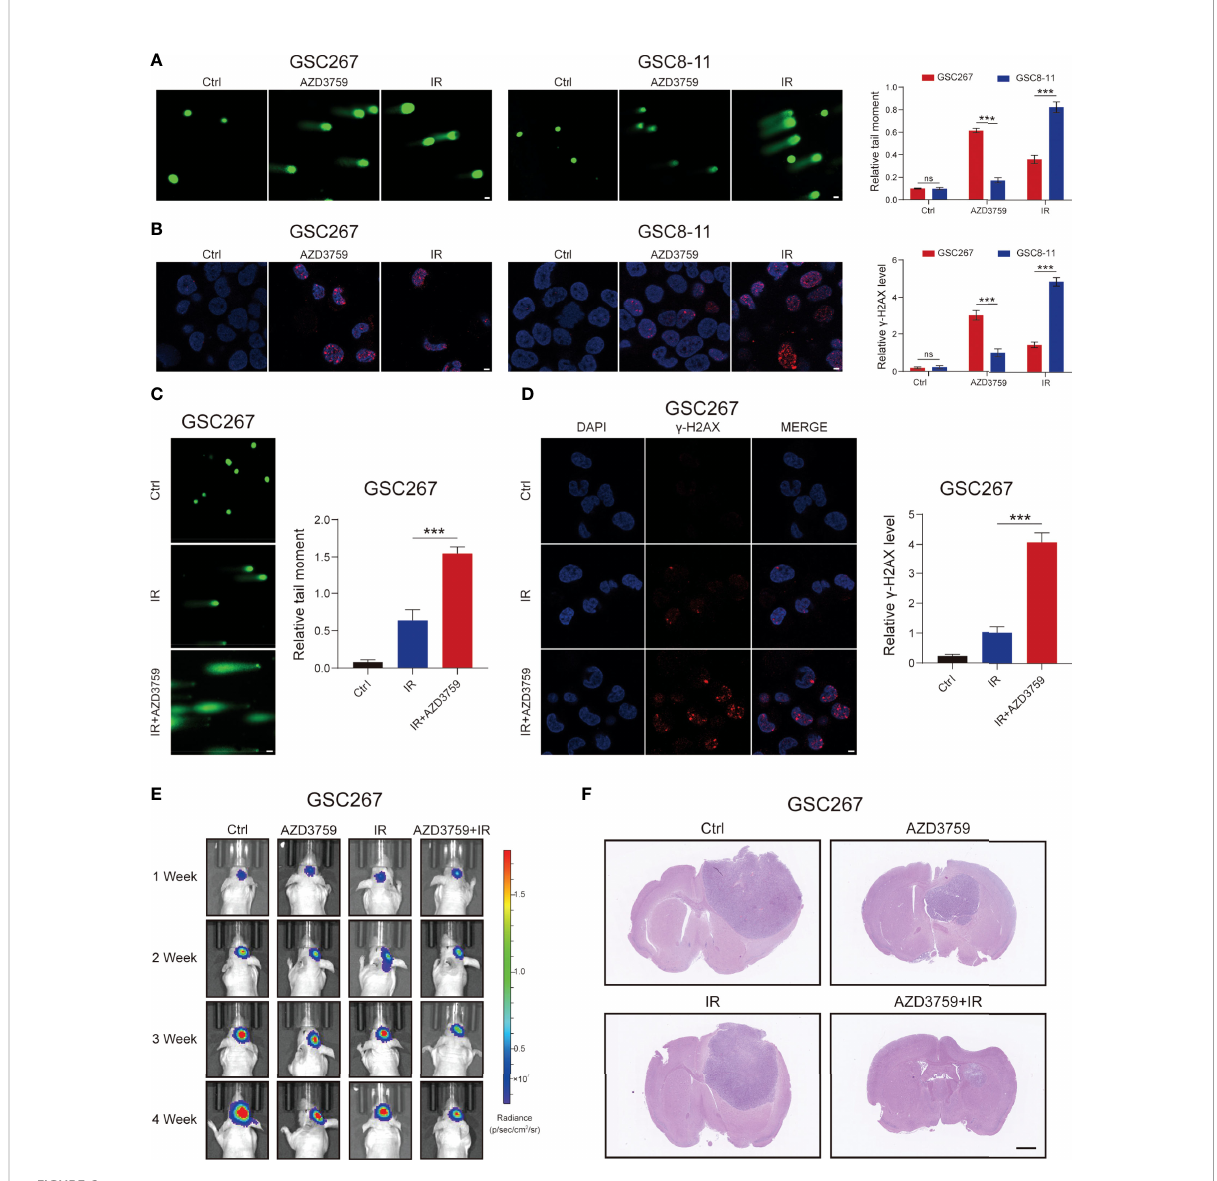
FIGURE 6 The MES GSC was more sensitive to AZD3759. (A) The comet assay showed the level of DNA damage in GSC267, and GSC8-11 treated with Zorifertinib or IR, respectively (scale bar=25 m m). The column plot represented the relative tail length. (B) Representative images and quanti fi cation of g -H2A.X staining in GSC267 and GSC8-11 treated with Zorifertinib or IR, respectively (scale bar=15 m m). (C, D) comet assay (C) and IF assay (D) presented the DNA damage level in GSC267. (E) Bioluminescence imaging of tumor size of mice implanted with fl uorescein- labeled GSC267. (F) H&E-stained brain sections of mice (scale bar=1 mm). All data are presented as the means ± SD, ns, P>0.05,